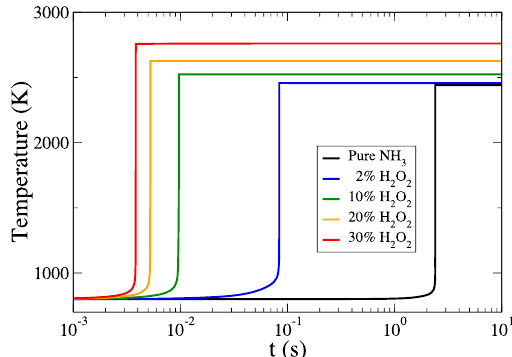
Figure 3. The evolution of temperature profiles for all cases considered.